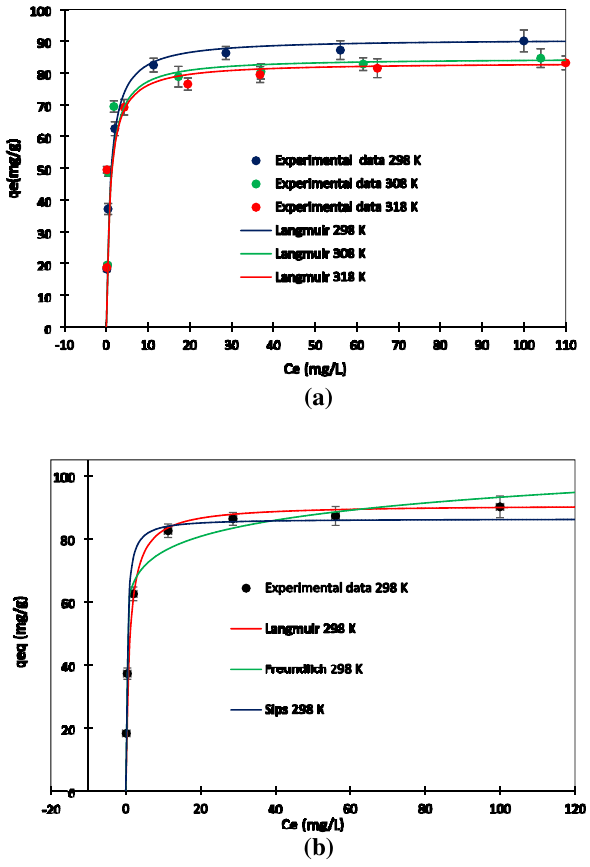
Figure 8. Equilibrium data from Pb 2+ adsorption onto AHCop. Error bars represent the standard deviation of three repeated experiments.